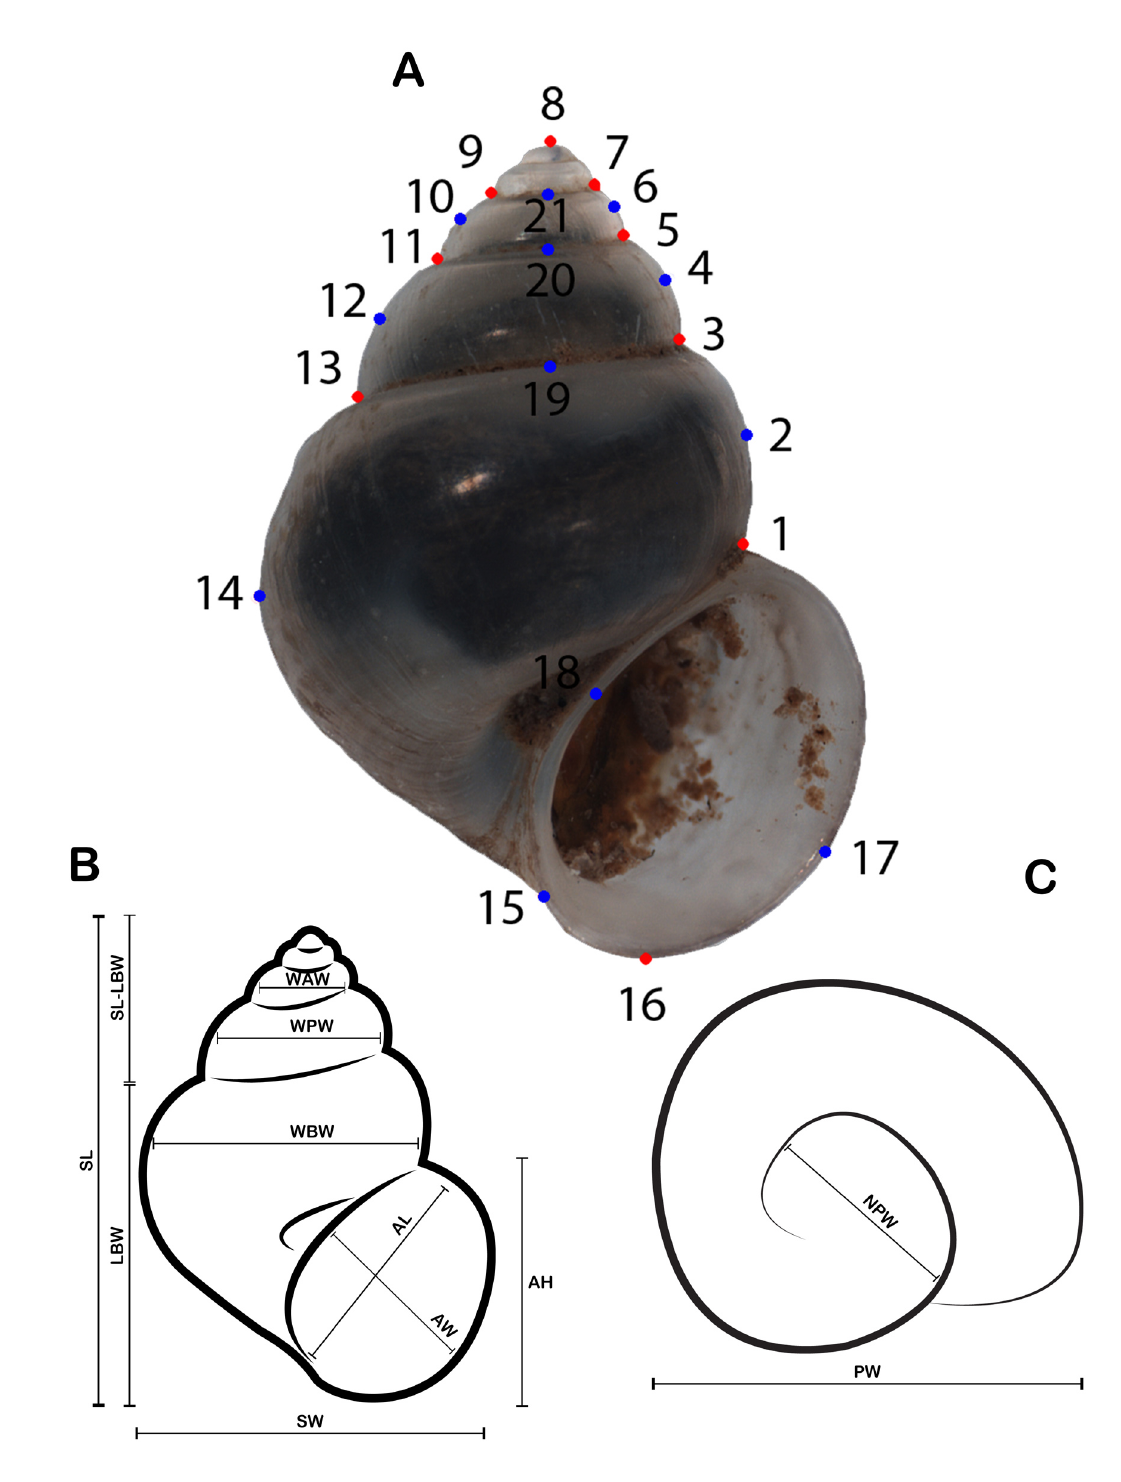
Fig. 2. Shell morphometric variables. A . Image of a specimen of Mercuria similis (Draparnaud, 1805) indicating the landmarks (red) and semilandmarks (blue) used for the geometric morphometric analysis (PCA). B–C . Drawings of shells of Mercuria Boeters, 1971, showing the linear measurements made on the shell and